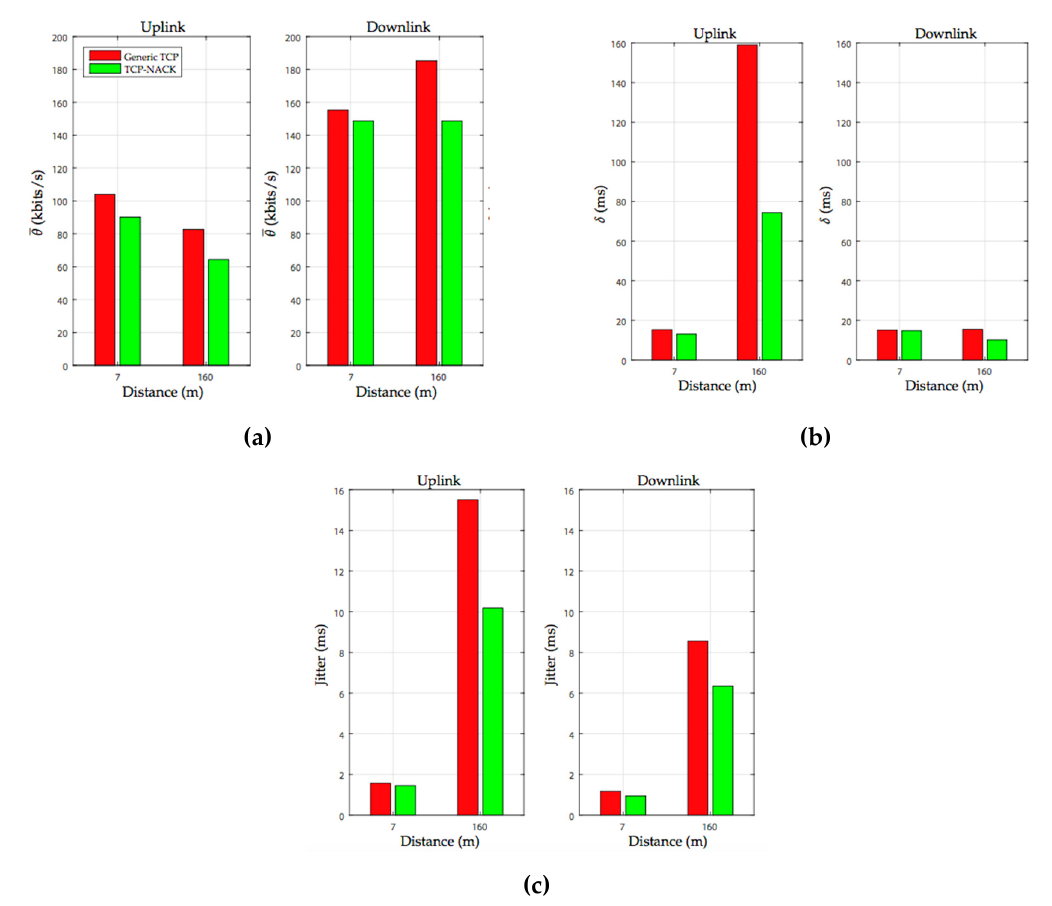
Figure 10. Short distance results: ( a ) θ ; ( b ) δ ; ( c ) jitter.